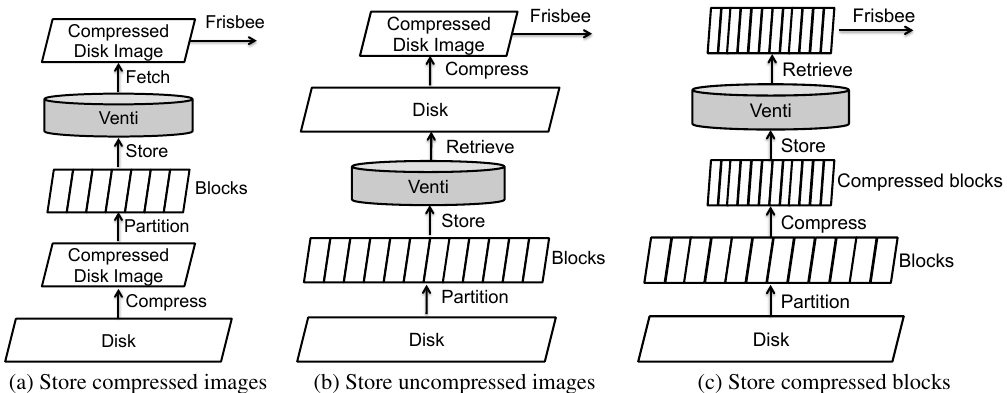
Figure 3: Three possible compression schemes.